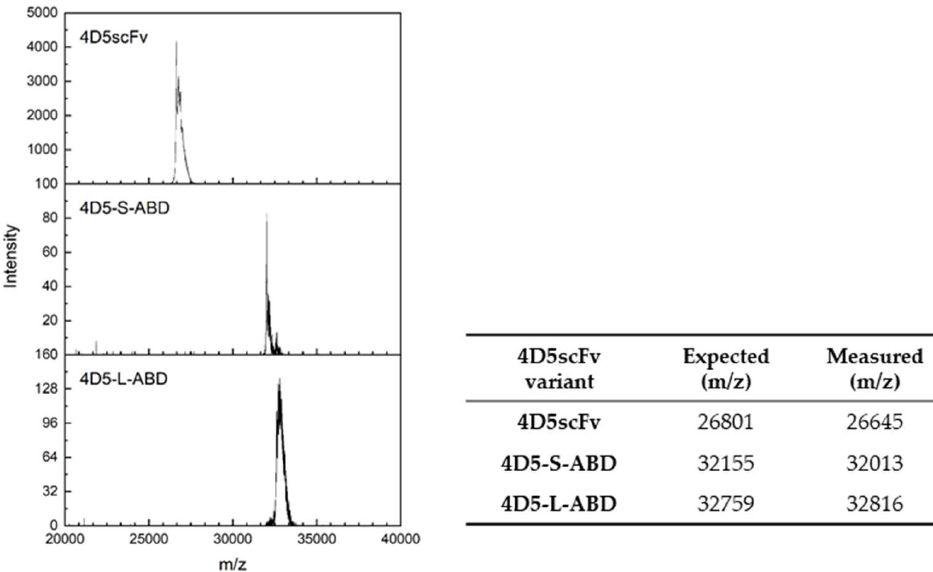
Figure 3. MALDI-TOF analysis of purified 4D5scFv and two 4D5-ABD variants.